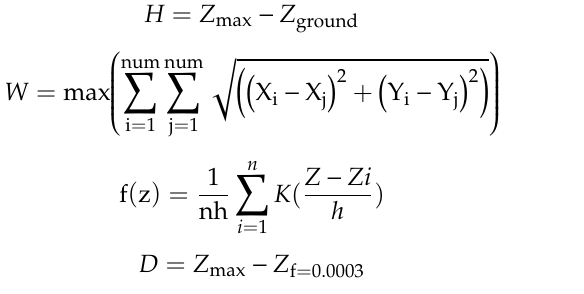
the height (H); ( b ) schematic diagram for the maximum tree width (W). height (H); ( b ) schematic diagram for the maximum tree width